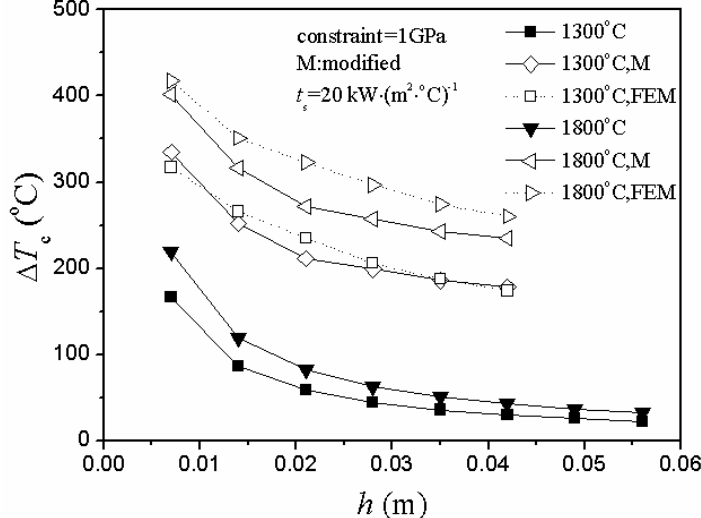
Figure 5. Relationship between critical rupture temperature difference, ∆ T thickness, h , including modified, unmodified and numerical simulation situations under different initial thermal shock temperature of cooling conditions (FEM represents finite element